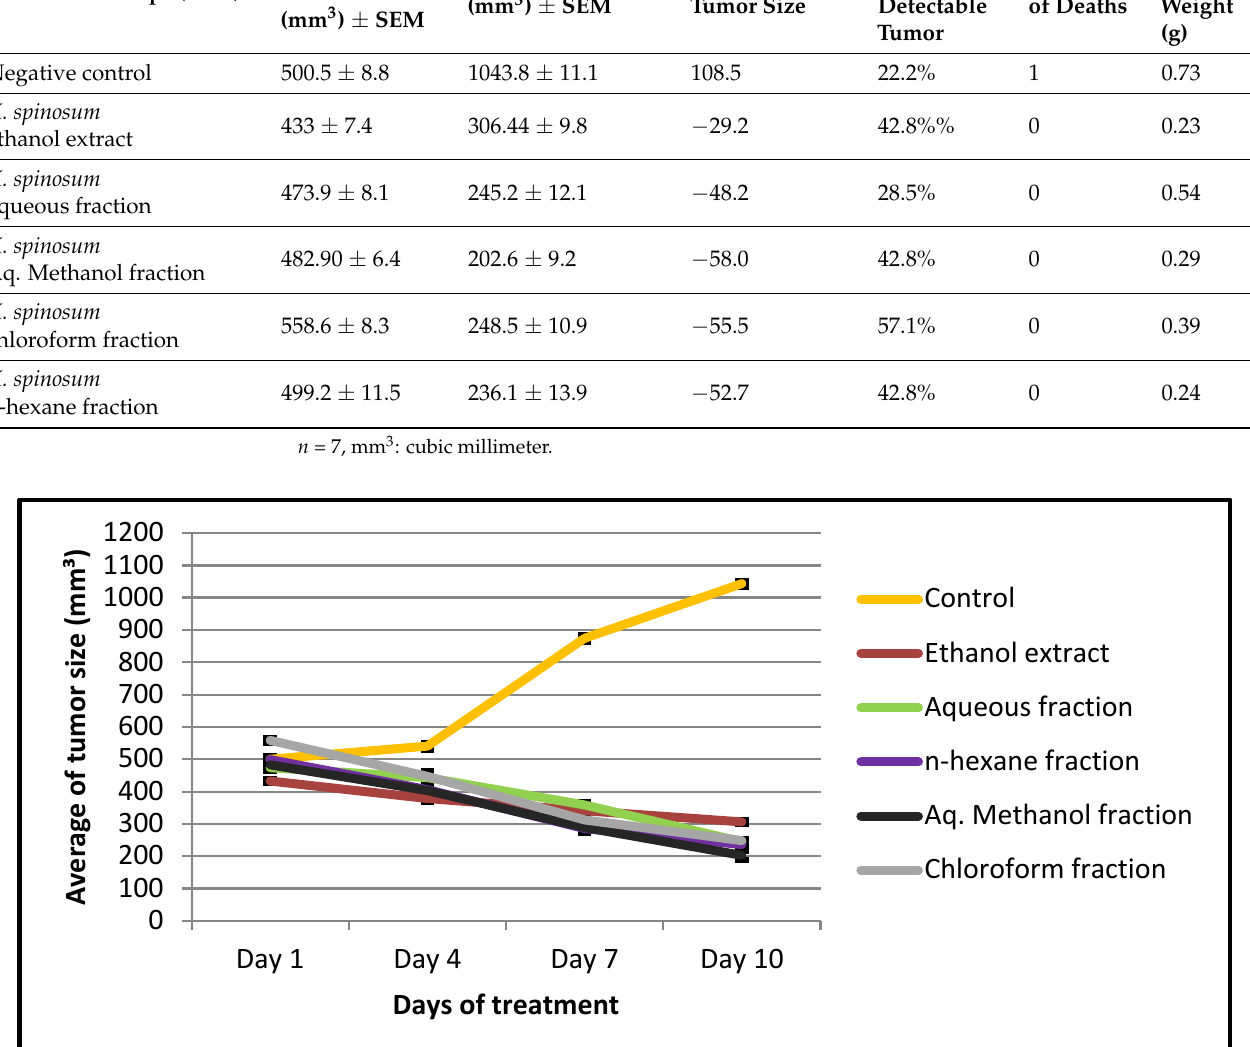
Figure 3. A plot demonstrated the changes in average tumor size (mm 3 ) vs. time (days) of treatment with X. spinosum extract and fractions in mice inoculated with the EMT6/P cell line. Tumor size is significant ( p < 0.05) compared to the negative control.